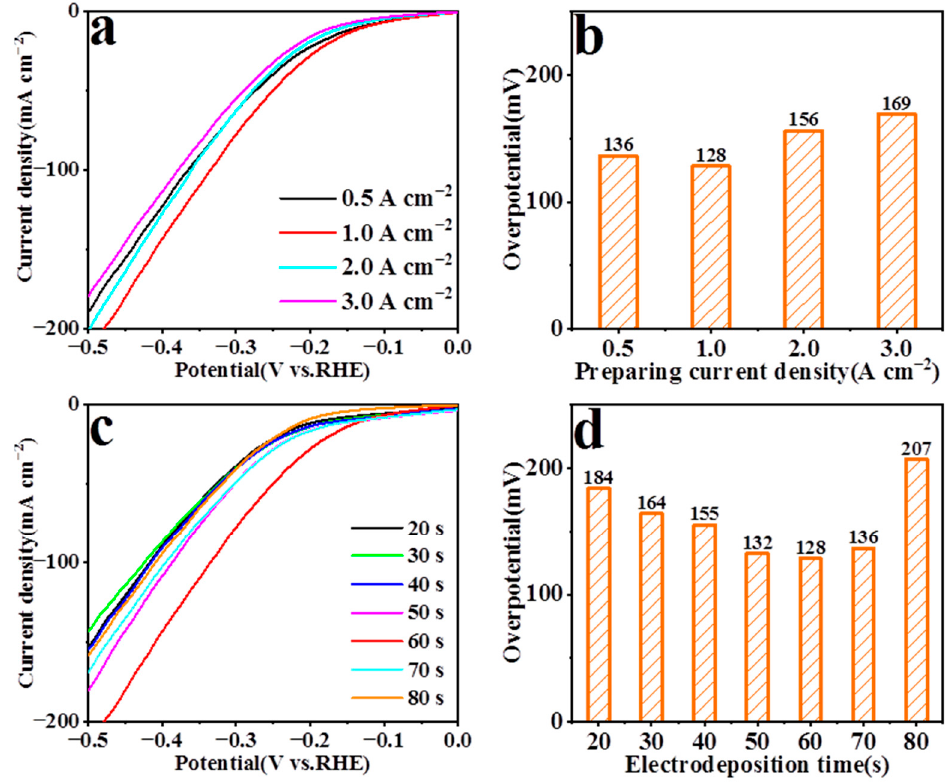
Figure 2. The LSV curves ( a ) and the overpotential at 10 mA cm − 2 ( b ) for HER of the pNF prepared at different current densities for 60 s. The LSV curves ( c ) and the overpotential at 10 mA cm − 2 ( d ) for HER of the pNF prepared for different electrodeposition times under 1.0 A/cm − 2 .